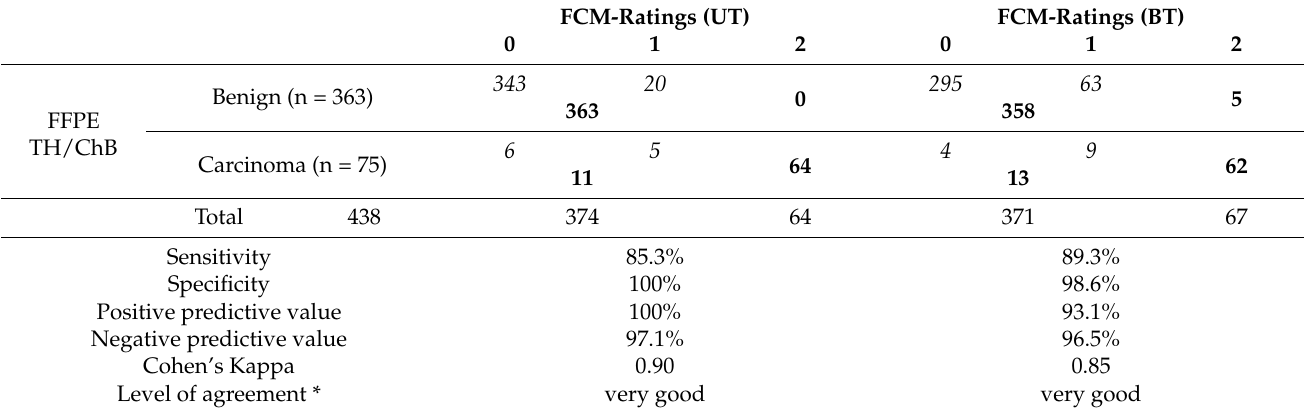
with the gold standard of HE morphology (Table 2). Table 2. Level of agreement between diagnoses in FCM images (UT, BT) and FFPE morphology (TH/ChB).